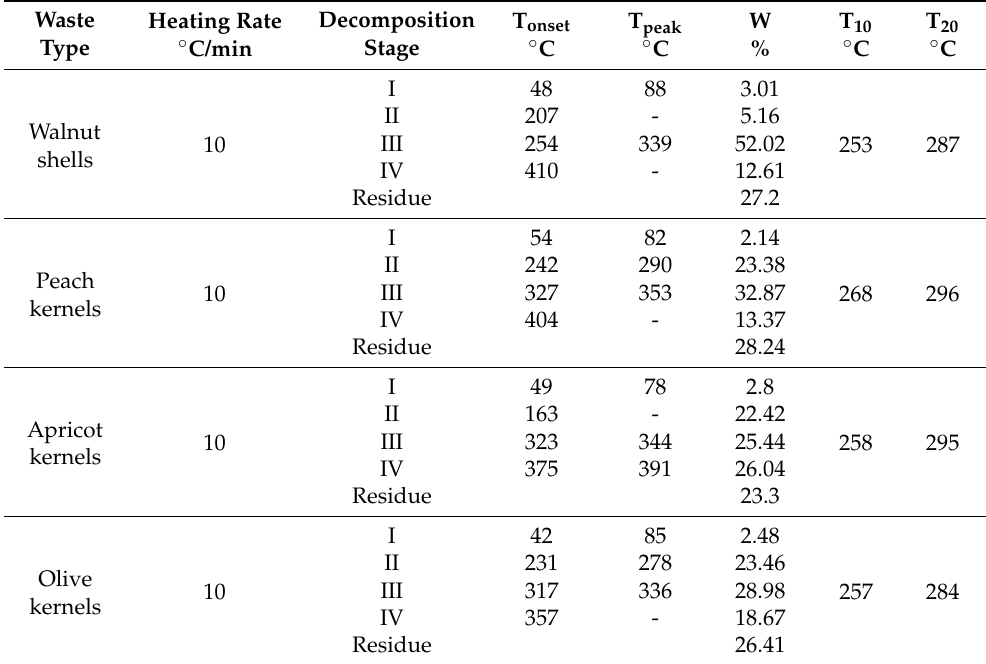
Table 3. Thermal parameters obtained by thermal pyrolysis of walnut shells, peach, apricot, and olive kernels in an inert gas atmosphere (N 2